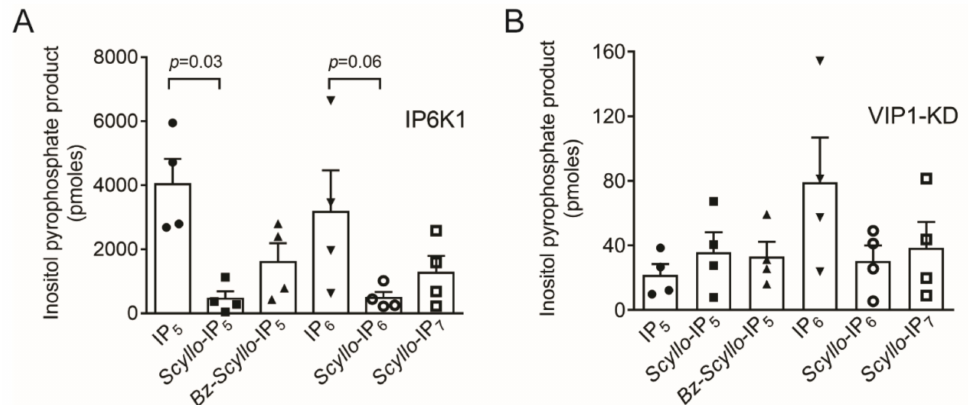
Figure 3. Extent of conversion of the substrates to products by ( A ) IP6K1 in presence of ATP (1 mM) and IPn (200 µ M). ( B ) VIP1-KD in presence of ATP (40 µ M) and IPn (100 µ M). PPIPn product formation was calculated as described in Section 3.3. The graphs show individual data points and mean ± SEM from four independent experiments. Data was analyzed using a two-tailed Mann–Whitney test to compare the PPIPn product of myo -IPn with its corresponding scyllo -derivative. p values are indicated where